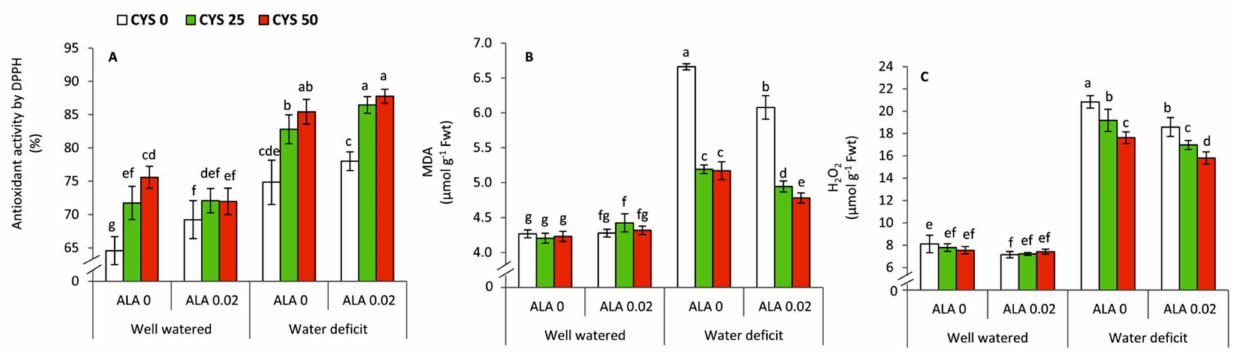
Figure 2. Effect of irrigation level, seed soaking by α -lipoic acid (ALA; 0 and 0.02 mM) and foliar application by cysteine (Cys; 0, 25 and 50 ppm) on the oxidative stress and scavenging capacity of wheat plants. ( A ) total antioxidant activity, ( B ) Lipid peroxidation (MDA), ( C ) Hydrogen peroxide content. For each parameter, the mean values ± SD followed by a different letter are significantly different according to Tukey’s range test ( p ≤